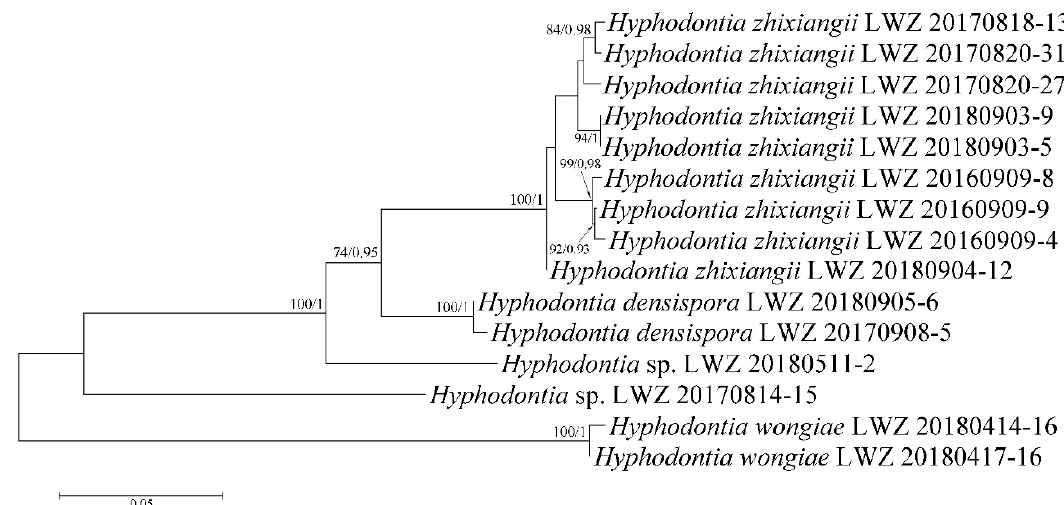
Figure 3. Phylogenetic relationship among species of Hyphodontia inferred from the combined dataset of ITS, nLSU, mt-SSU, tef1 α , rpb1 and rpb2 regions. The topology generated by the maximum likelihood algorithm is presented along with the bootstrap values and the Bayesian posterior probabilities above 50% and 0.8, respectively, at the nodes.